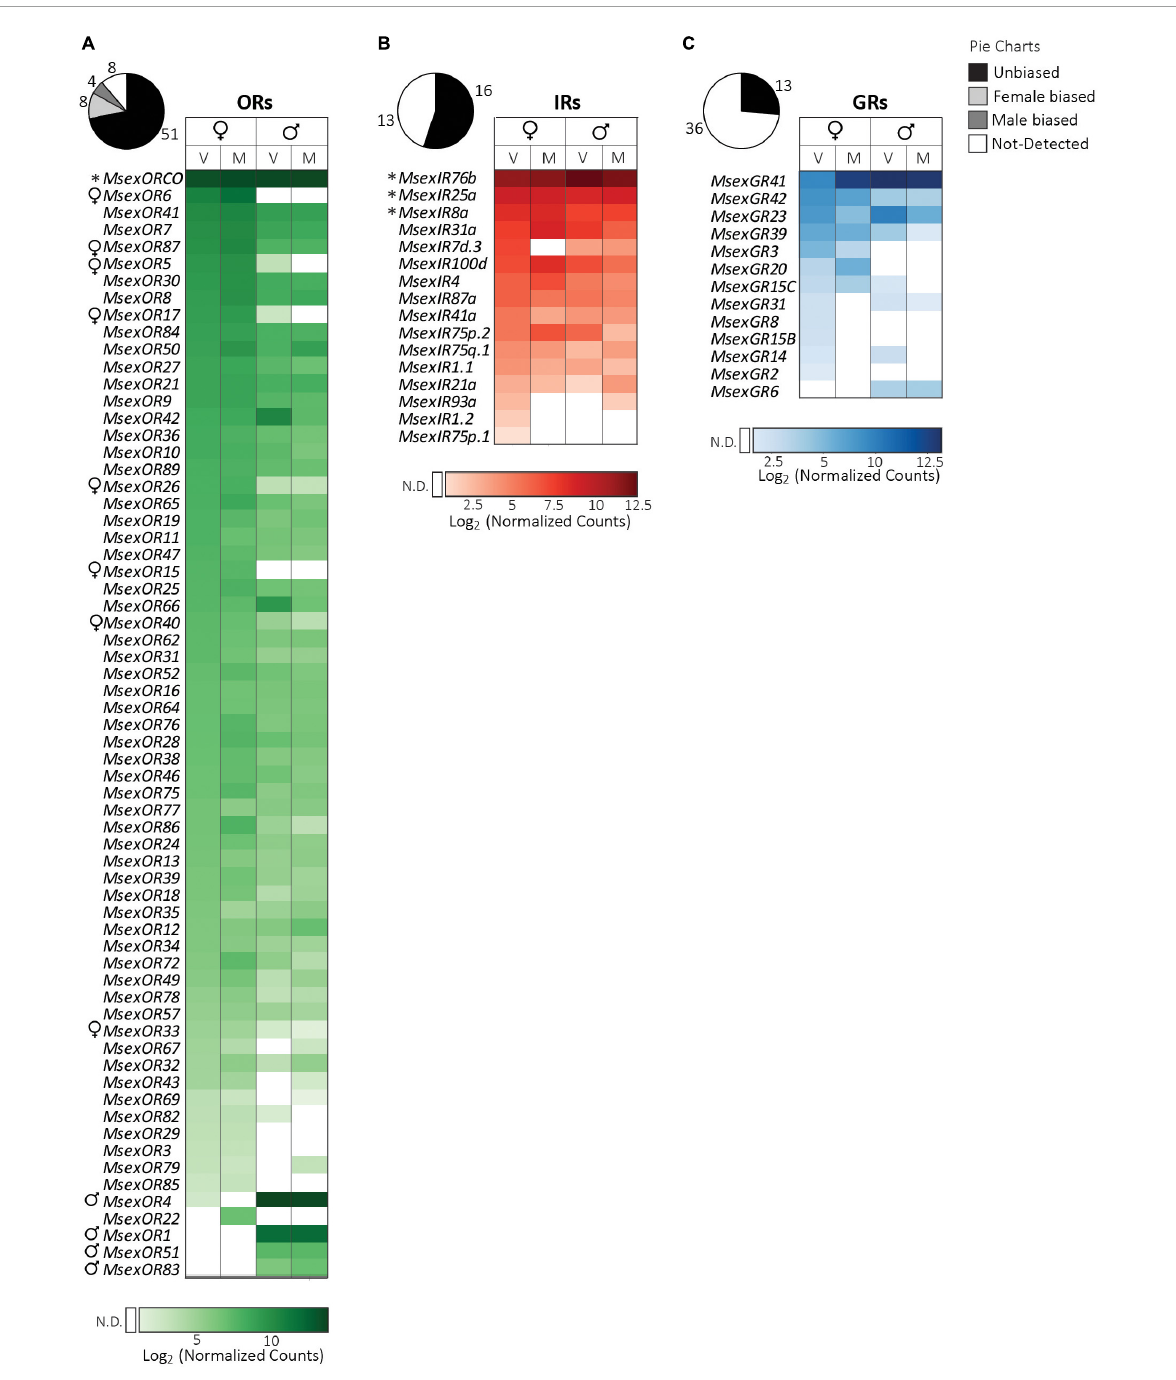
, female-biased receptors; , ♀ ♂